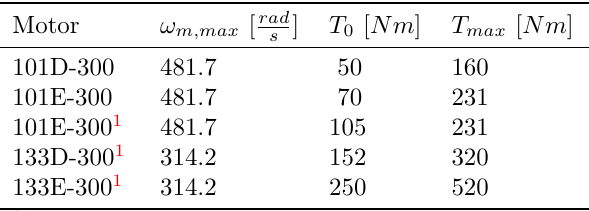
Table 3: IndraDyn S - servo motor MSK data